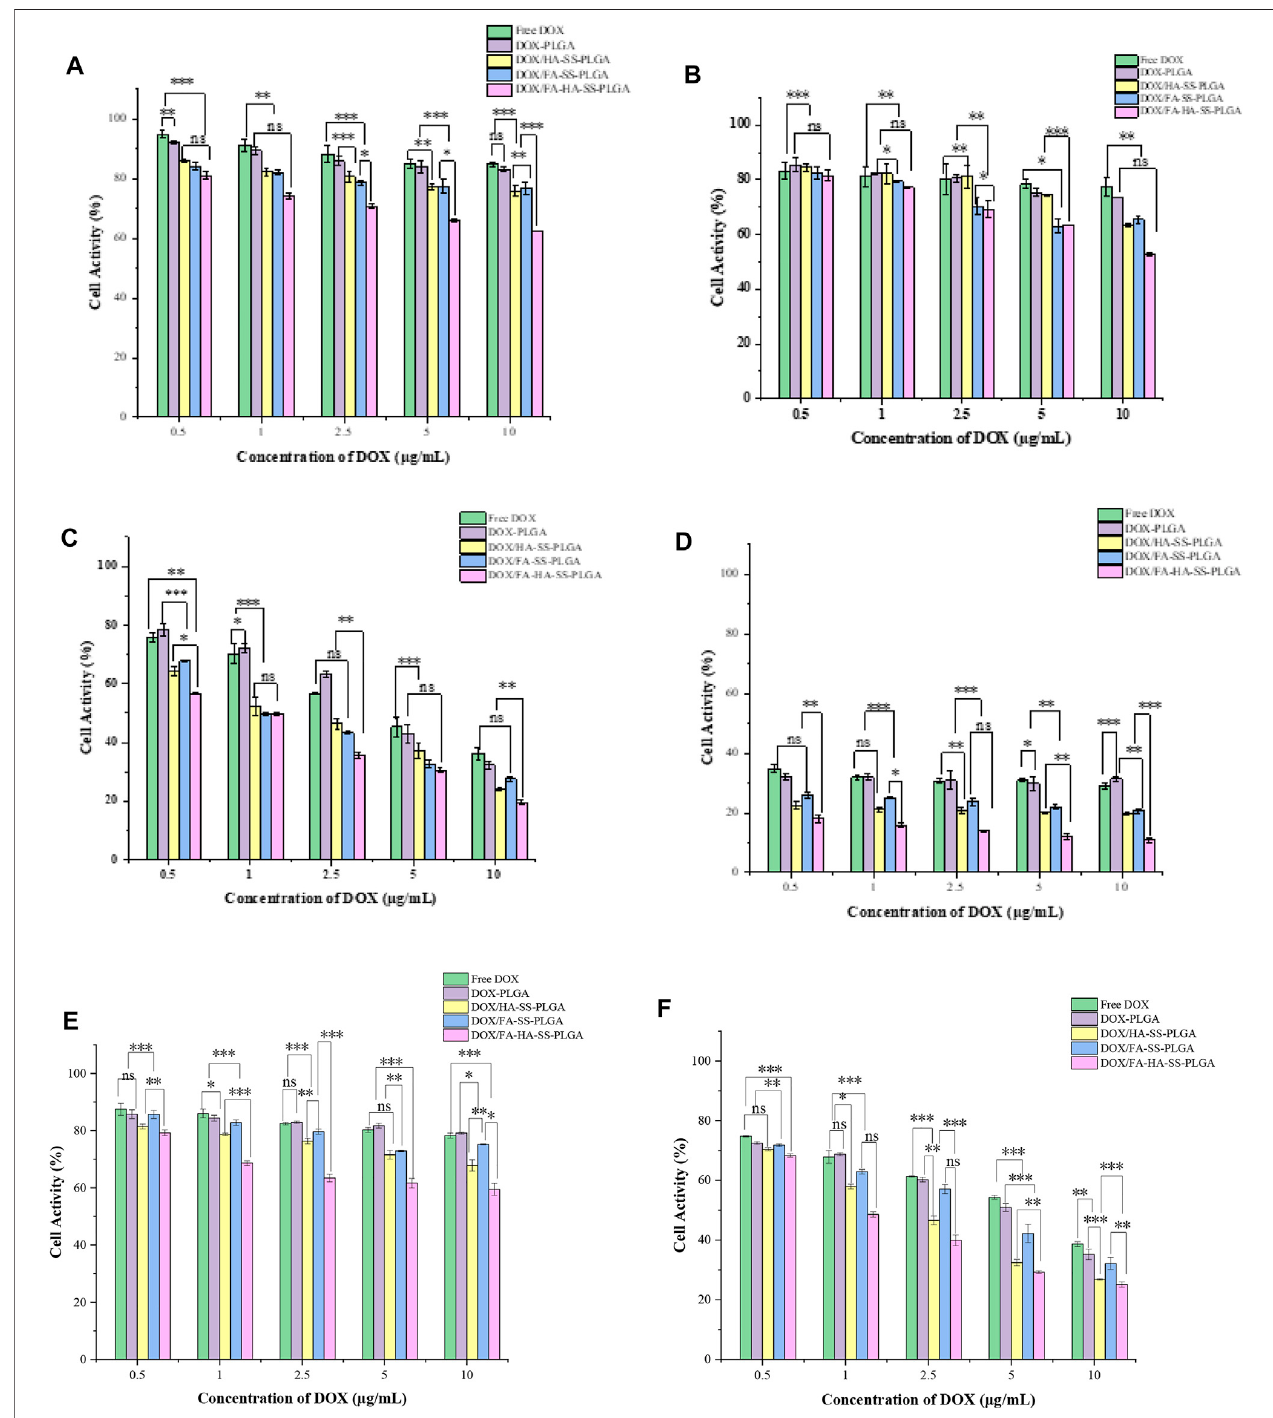
FIGURE 8 | Tumor cell activity. (A) Human breast cancer cells (MCF-7) cells were cultured for 12 h. (B) MCF-7 cells were cultured for 24 h. (C) MCF-7 cells were culturedfor48 h. (D) MCF-7cellswereculturedfor72 h. (E) A549cellswereculturedfor24 h. (F) A549cellswereculturedfor48 h. (G) CellcultureofCT26for24 h. (H) CT26 cell culture for 48 h. (I) IC 50 values of free DOX and different drug-loaded micelles on MCF-7, A549, and CT26 cells cultured for 48 h. The data were expressed as mean ± SEM( n = 3). (J) Effectsofblankmicellesatdifferentconcentrationsoncellviabilityafter48 hofMCF-7cellculture. (K) ApoptosisofMCF-7cellstreatedfor 12 h with DOX-PLGA, DOX/HA-SS-PLGA, DOX/FA-SS-PLGA, and DOX/FA-HA-SS-PLGA.